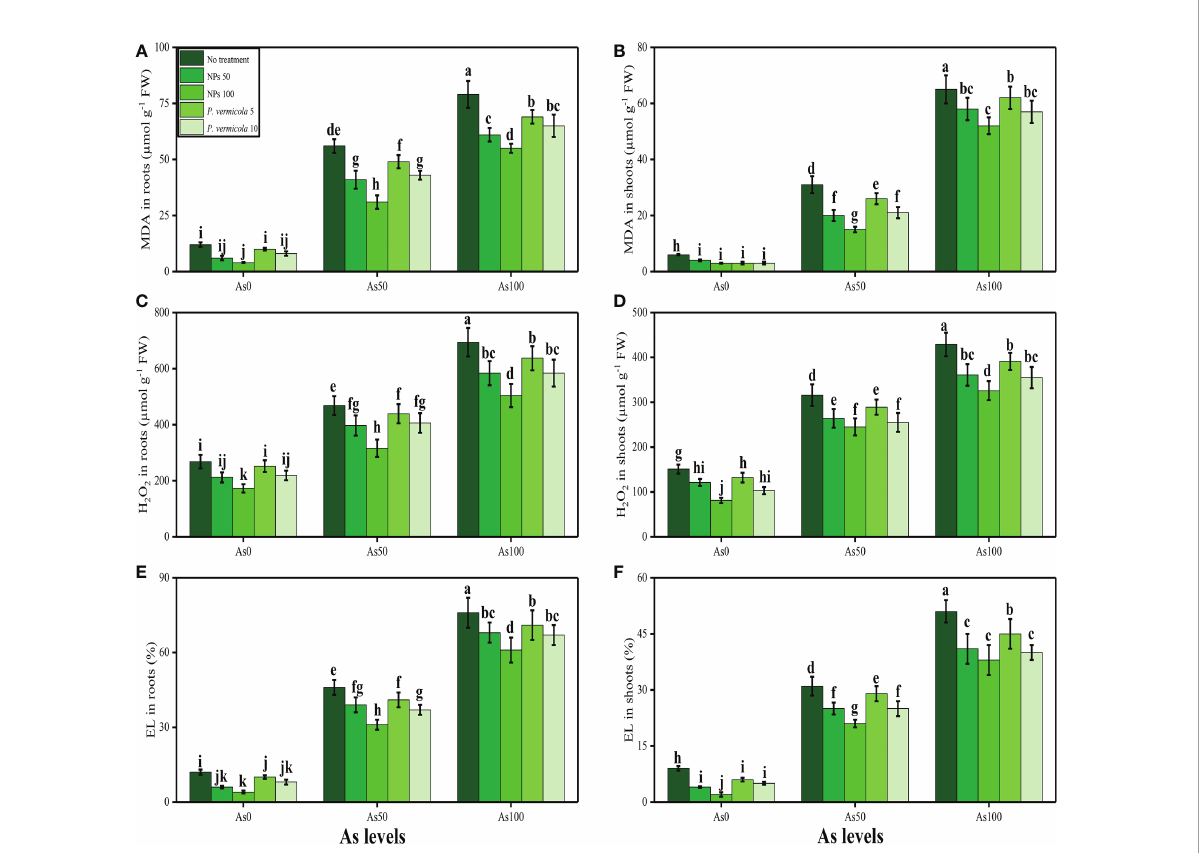
FIGURE 3 Effect of combined application of various levels of iron oxide nanoparticles (FeO-NPs) (i.e., 50 mg/l − 1 and 100 mg/l − 1 ) and plant growth- promoting bacteria ( Providencia vermicola ) (i.e., 5 ppm and 10 ppm) on malondialdehyde (MDA) contents in the roots (A) , MDA contents in the leaves (B) , hydrogen peroxide (H 2 O 2 ) contents in the roots (C) , H 2 O 2 contents in the leaves (D) , EL percentage in the roots (E) , and EL percentage in the leaves (F) of Ajwain ( Trachyspermum ammi seedlings) grown under various stress levels of arsenic (i.e., 0 m M, 50 m M, and 100 m M). Values are demonstrated as means of four replicates along with standard deviation (SD; n = 4). Two-way ANOVA was performed and means differences were tested by Tukey ’ s highly signi fi cant difference post-hoc test ( p < 0.05). Different lowercase letters on the error bars indicate signi fi cant difference between the